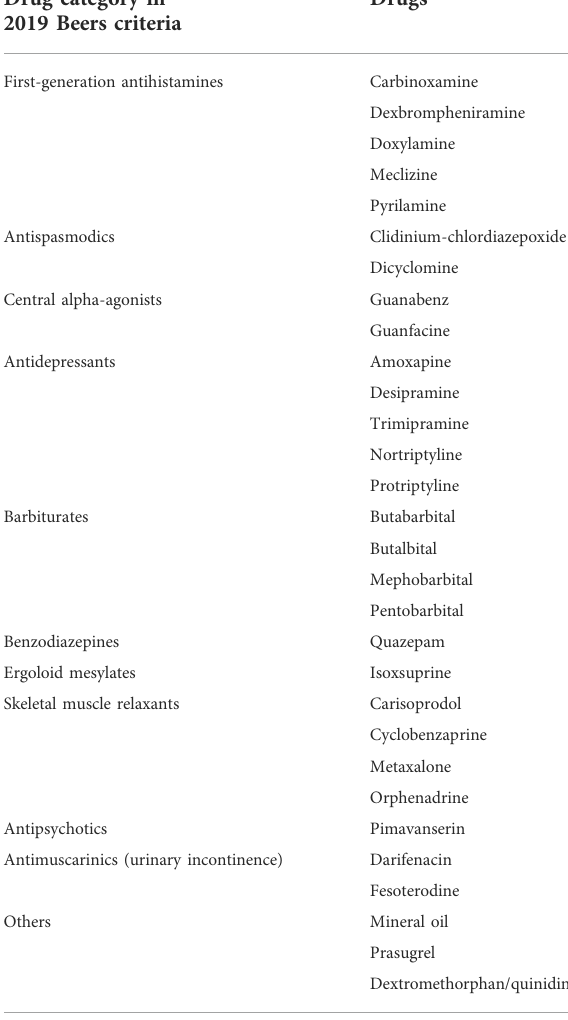
TABLE 5 Medications from the 2019 Beers criteria not available in